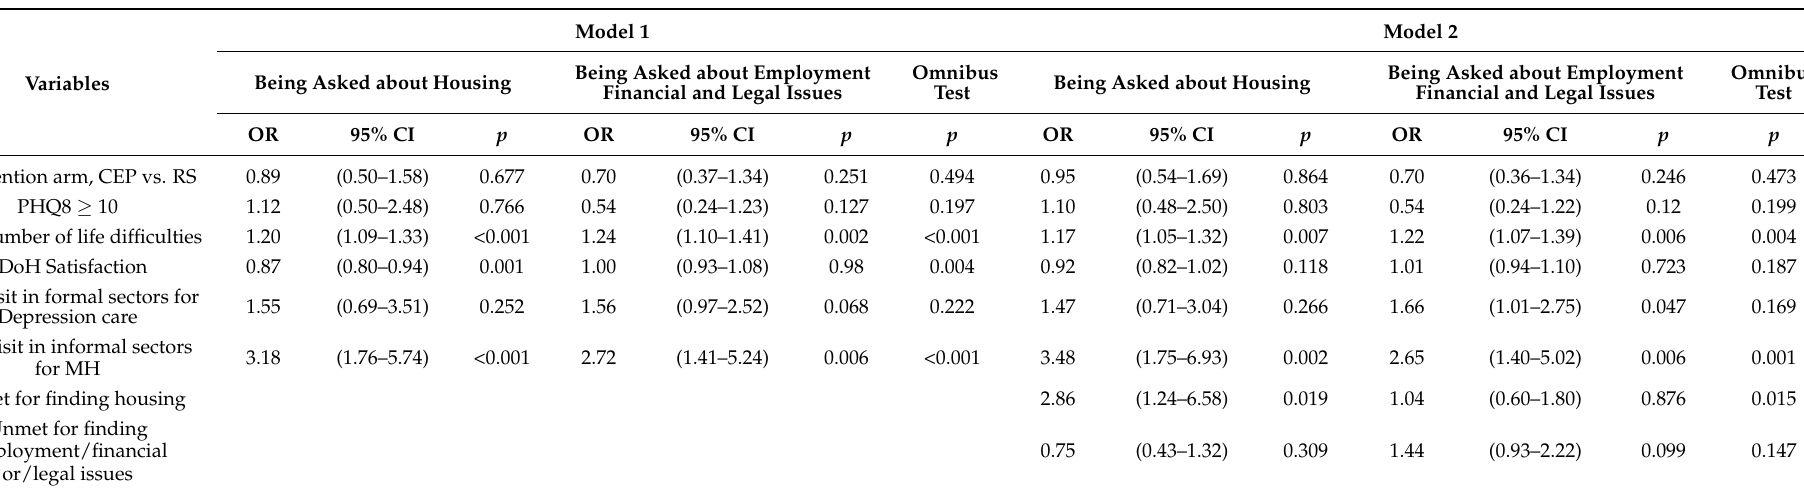
Table 2. Models for being asked about housing and employment financial and legal issues at 36 months, by perceived life difficulties and service utilization controlling for intervention